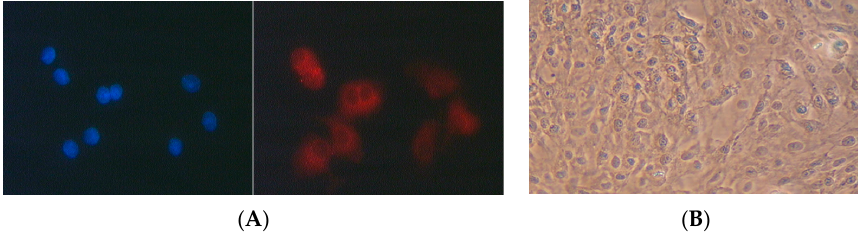
Figure 1. ( A ) Immunocytochemical detection of the lamellar body membrane protein in five day old cultures of pneumocyte type II cells—counterstaining with DAPI; ( B ) phase contrast micrograph of proliferating pneumocytes after five days in culture—arrows indicate metaphases.